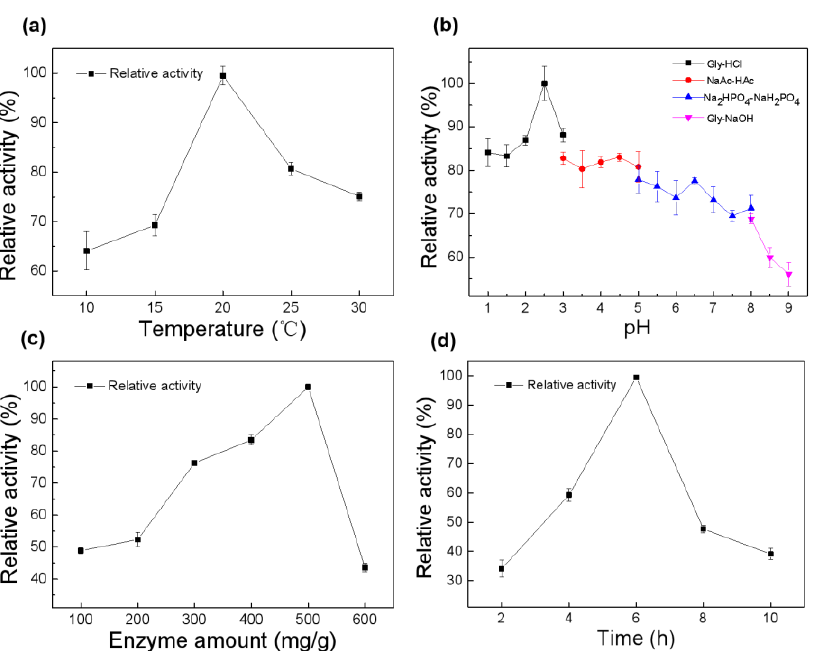
Figure 2. The optimization of site-specific covalent condition for Melac13220; ( a ) the optimization of temperature; ( b ) the optimization of pH; ( c ) the effect of enzyme loading rate on the activity of immobilized Melac13220; ( d ) the effect of reaction time on the activity of immobilized Melac13220. All experiments were performed in triplicate, and the results represent mean ± standard deviation.